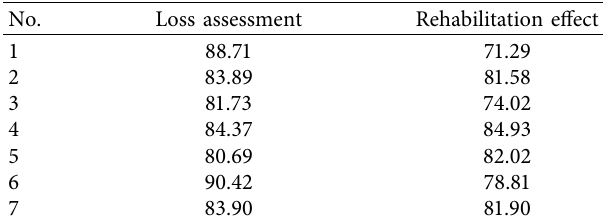
Figure 16: Statistical diagram of system performance test Table 3: Statistical table of system practice effect.